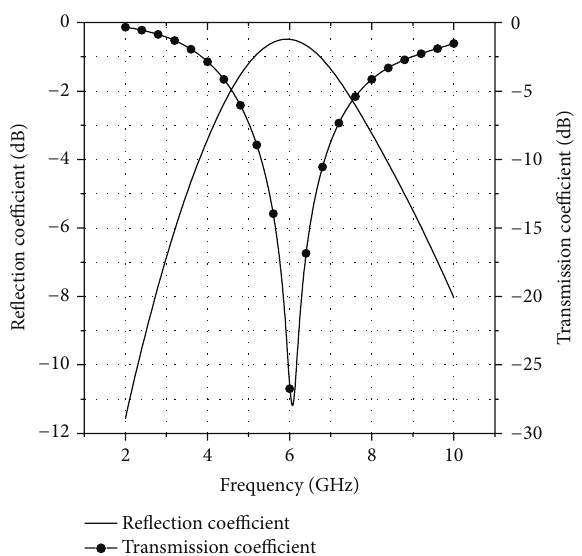
Figure 5: T-shape DMS structure frequency